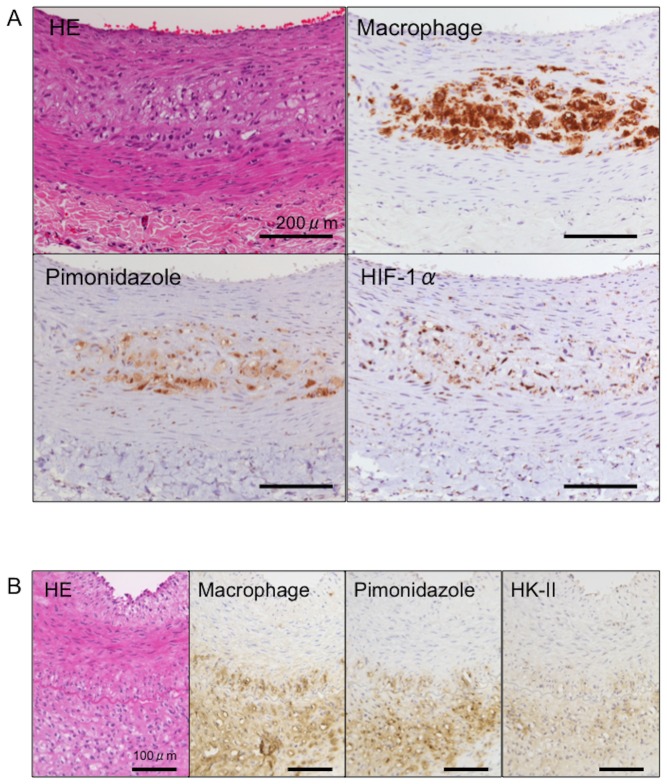
Immunohistochemical findings of HIF-1α and HK-II in iliac-femoral artery with macrophage-rich neointima.Immunohistochemical staining for macrophages, pimonidazole and HIF-1α in paraffin sections (A) and for macrophages, pimonidazole and HK-II in frozen sections (B)